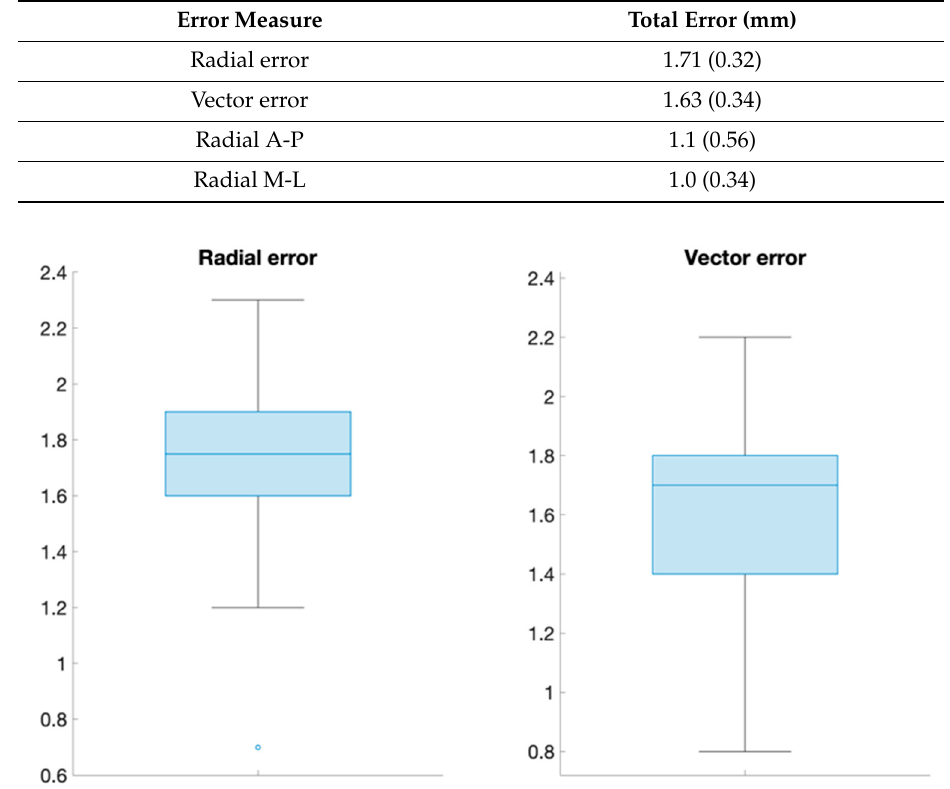
Figure 3. Boxplots showing the radial and vector errors.